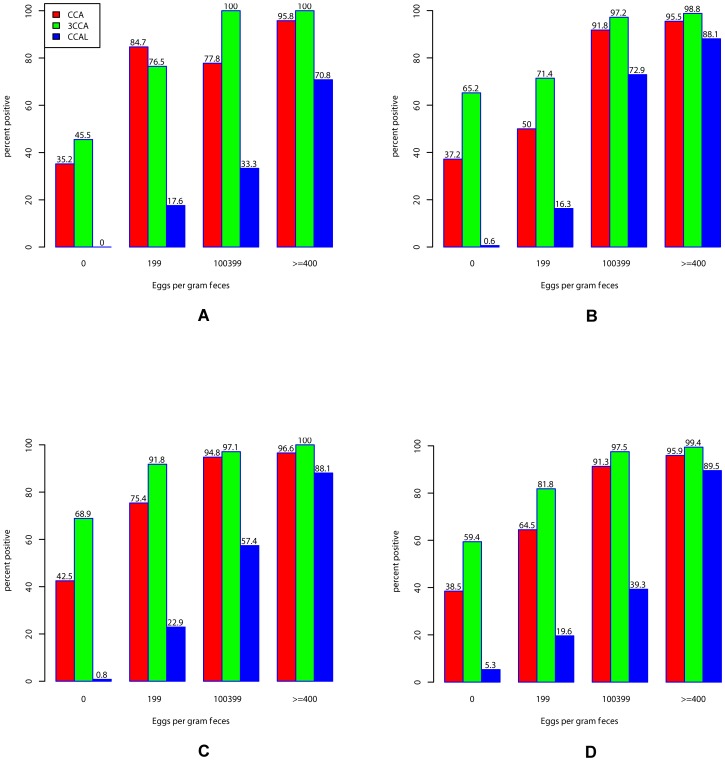
Correlation between S. mansoni infection intensities and CCA results.The prevalences of CCA (single CCA, triple CCA and CCA-L) are affected by the abundance of S. mansoni infection (stratified by intensity classes). A = setting 1, B = setting 2, C = setting 3, D = All settings A-B-C.